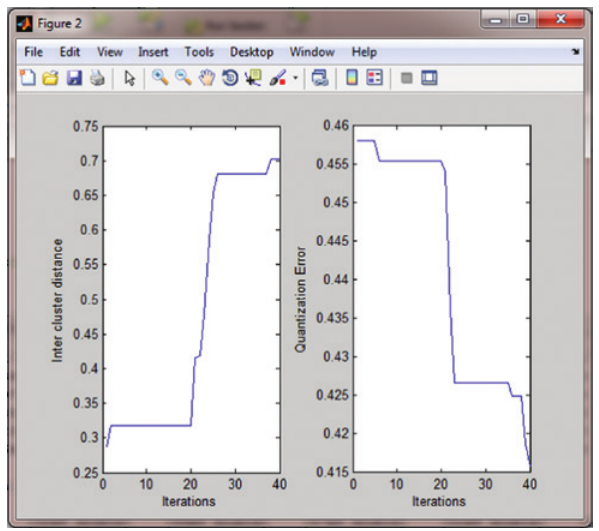
Figure 2: Optimization of Inter-cluster Distance and Quantization Error.